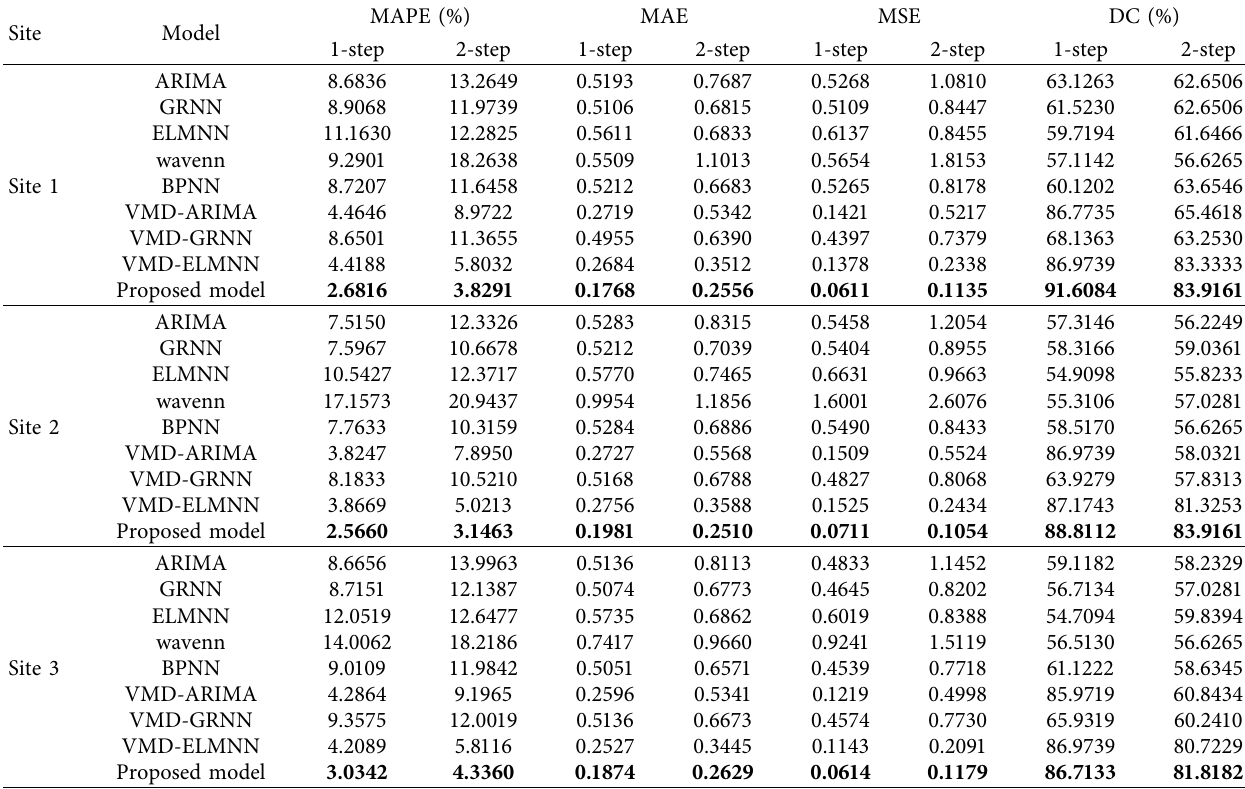
Table 5: Prediction abilities of the established model and single